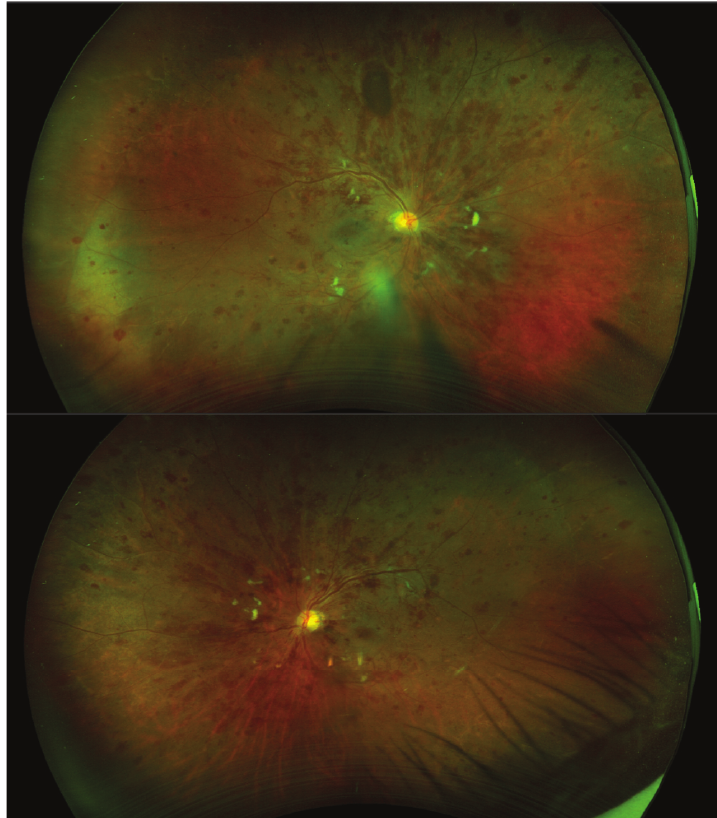
Figure 1. Color fundus images of the right (above) and left (below) eyes, showing a blunted foveal reflex, scattered hemorrhages, and dilated tortuous